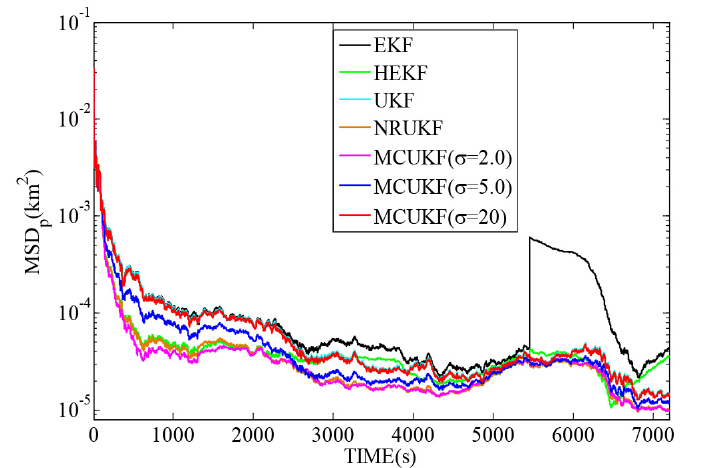
Figure 6. MSD p with different filters in non-Gaussian